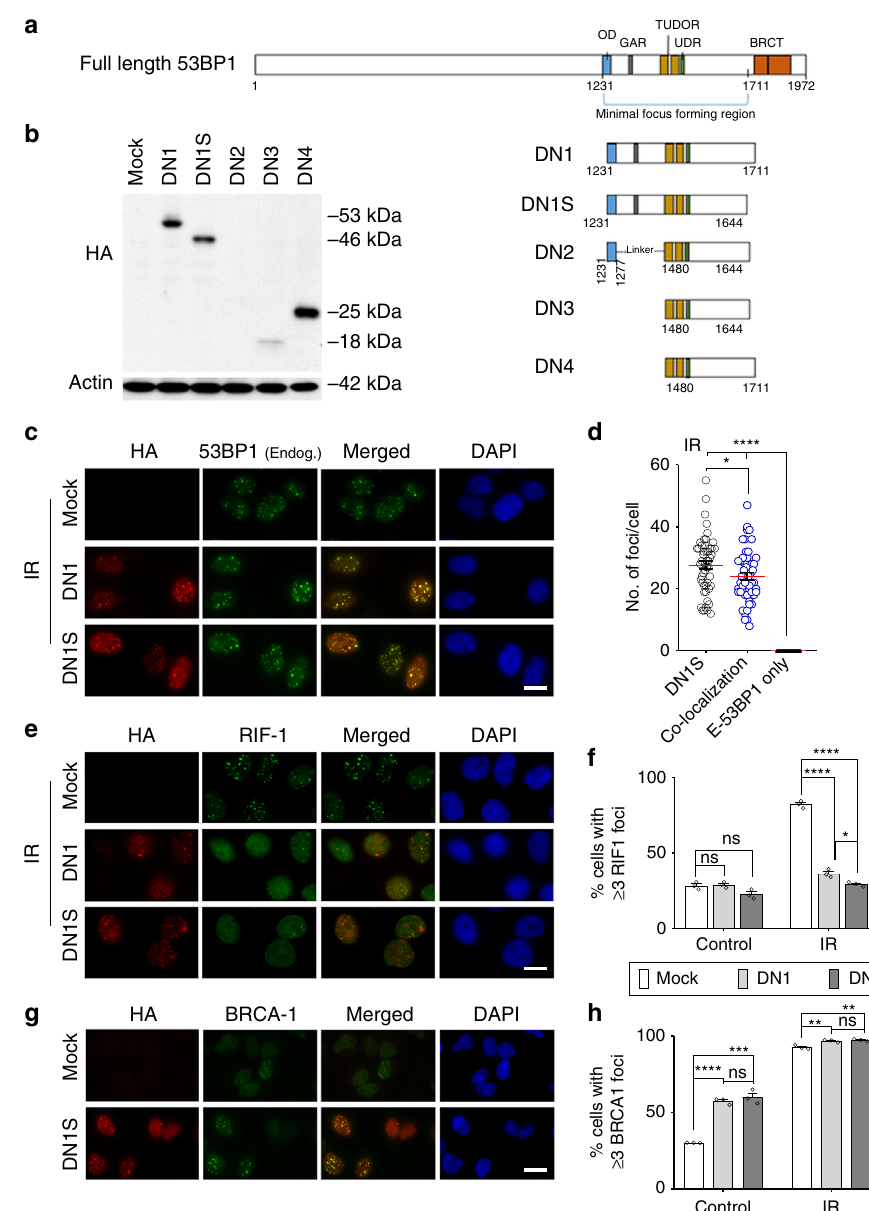
Fig. 1 Identi fi cation of an HDR-enhancing fragment of 53BP1. a Schematic diagram of full-length human 53BP1 protein showing the minimal focus forming region including the oligomerization domain (OD), a glycine-arginine rich (GAR) motif, a tandem Tudor domain, and the ubiquitin-dependent recruitment (UDR) motif. BRCT repeats at the extreme C-terminus are present. b Different truncated 53BP1 proteins, DN1, DN1S, DN2, DN3, and DN4, were tested for their relative expression by western blot using anti-HA antibody in HeLa cells transduced with empty vector (mock) or lentiviral vectors encoding HA- tagged 53BP1 fragments DN1, DN1S, DN2, DN3, or DN4. Actin is shown as a loading control. c , e , g Representative immuno fl uorescence (IF) images of HA- tagged DN1 and DN1S at nuclear foci. Cells were either exposed to 2 Gy IR or no IR (control) and fi xed 2 h later. Scale bars represent 20 μ m. c Representative IF images showing co-localization of HA-tagged DN1 or DN1S with endogenous 53BP1 foci. d Number (no.) of HA + (DN1S) foci, co- localized HA + /endogenous 53BP1 + (co-localization) foci, or endogenous 53BP1 + (E-53BP1) only foci per IR-treated HeLa cell expressing DN1S. Individual quanti fi cations of foci from 50 cells in each group are shown. Red lines are drawn at the mean number of foci per positive cell. e Representative IF images showing HA-tagged DN1 or DN1S and RIF1 recruitment to IR-induced DNA repair foci. f Quanti fi cation of cells with ≥ 3 RIF1 foci in control cells or IR cells with DN1, DN1S or without vector (mock). g Representative IF images showing HA-tagged DN1S and BRCA1 recruitment to DNA repair foci in control cells. h Quanti fi cation of the number of cells with ≥ 3 BRCA1 foci in control cells or IR cells, with DN1, DN1S or without vector (mock). In panels f and g , data are presented as the mean ± SEM of counts of 150 cells each, from three independent fi elds, and black circles indicate individual counts. Statistics for panels d , f , and g : ANOVA. ns indicates not signi fi cant, * p < 0.05, *** p < 0.001, and **** p < 0.0001. Source data is available in Source Data fi